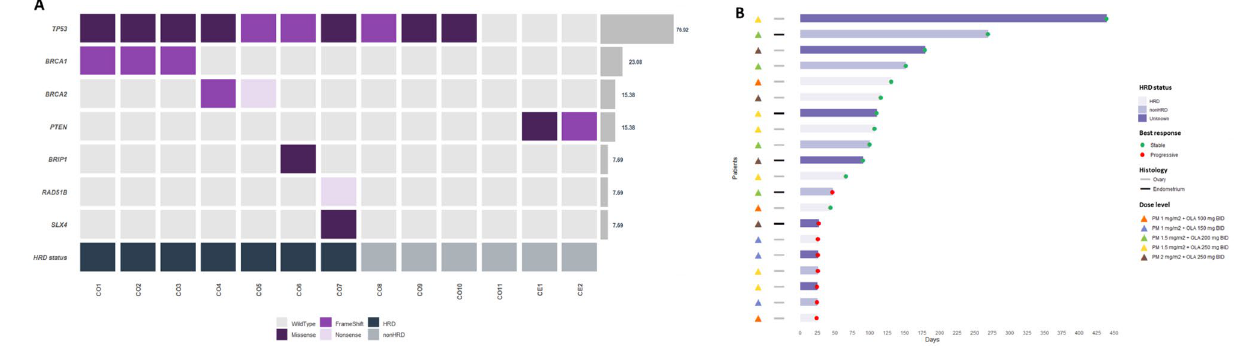
Figure 4. ( A ) Frequency of alterations across the studied DNA repair genes. ( B ) Main prognostic, histologic and molecular features of tumors included in the trial. *CO and CE correspond to histology type (Ovarian and endometrium, respectively).